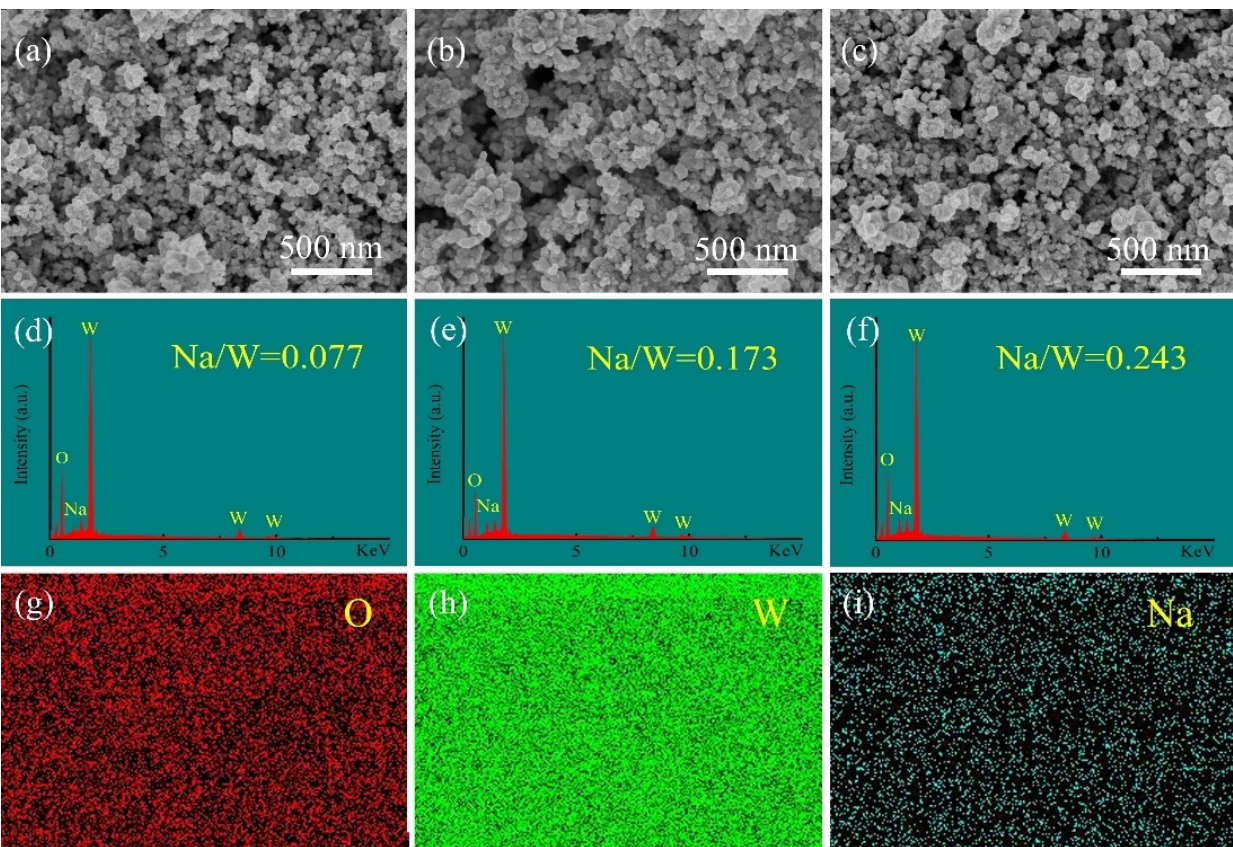
Figure 3. SEM images of Na x WO 3 synthesized with the Na/W ratio of ( a ) 1:1, ( b ) 3:1, ( c ) 5:1; corresponding EDS images ( d ) 1:1, ( e ) 3:1, ( f ) 5:1; element mapping of sample with Na/W ratio of 1:1 ( g ) O, ( h ) W, ( i ) Na.